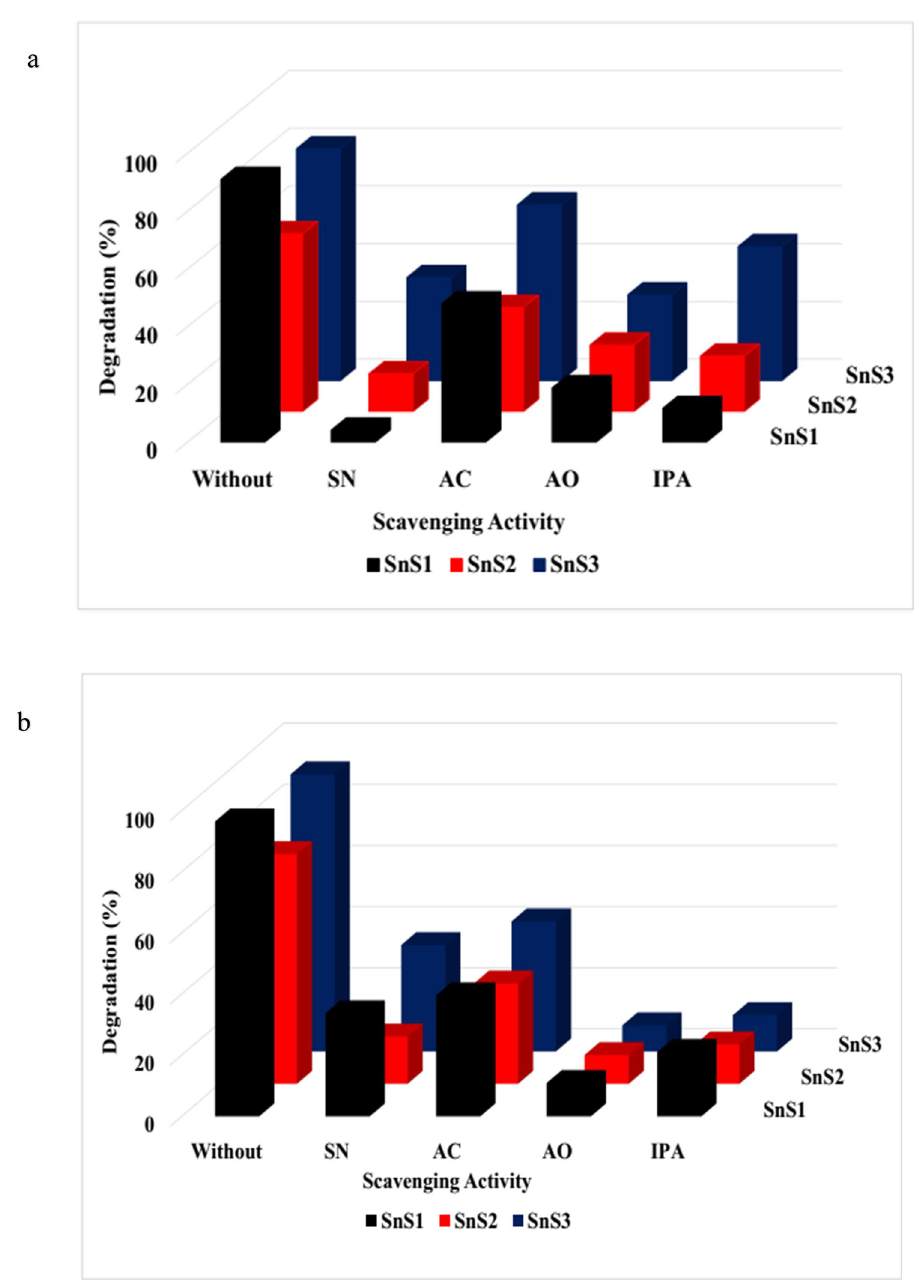
Figure 6: ( a ) E ff ect of scavengers on the photodegradation of rhodamine B and ( b ) phenol, by SnS